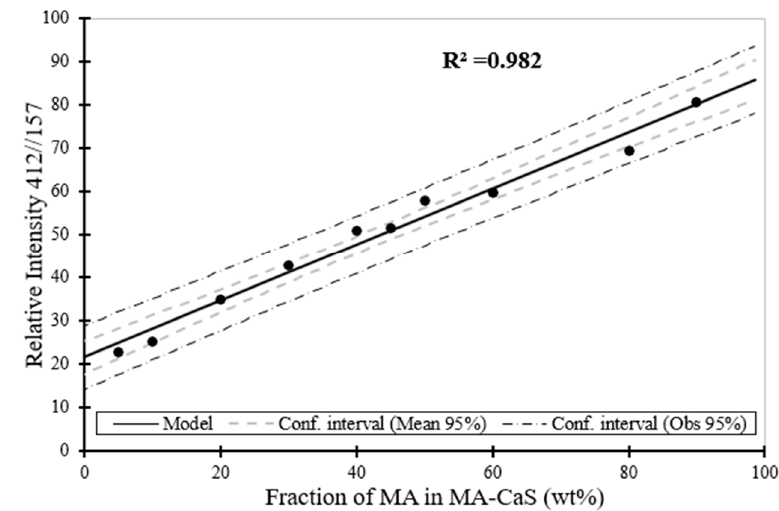
Figure 12. Raman spectroscopy estimation for the phase content (wt. %) for MA as a function of the phase content of MA in MA–CaS sample.